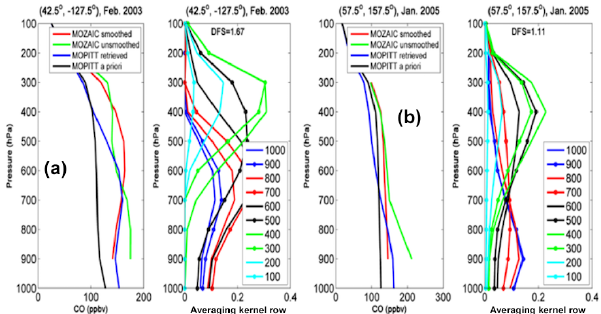
Figure 3. Examples of comparisons of monthly means of the trajectory-mapped MOZAIC-IAGOS CO profiles, with the corre- sponding MOPITT averaging kernels, a priori and retrievals. The left panels of each subplot show the original trajectory-mapped MOZAIC-IAGOS climatology profile (green, i.e. unsmoothed), the a priori profile, the transformed trajectory-mapped MOZAIC- IAGOS climatology profile (red, i.e. smoothed), and the MOPITT- retrieved CO profile. The right panel show the mean averaging ker- nels, for different pressure levels, obtained by averaging all daytime averaging kernels in the 5 ◦ × 5 ◦ latitude–longitude box centered on the coordinates